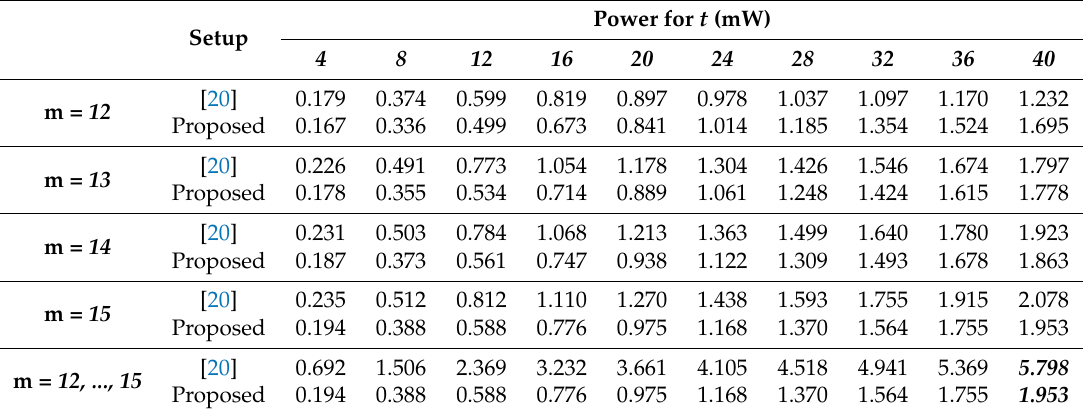
Table 3. Power comparison for different syndrome generators vs. the proposed